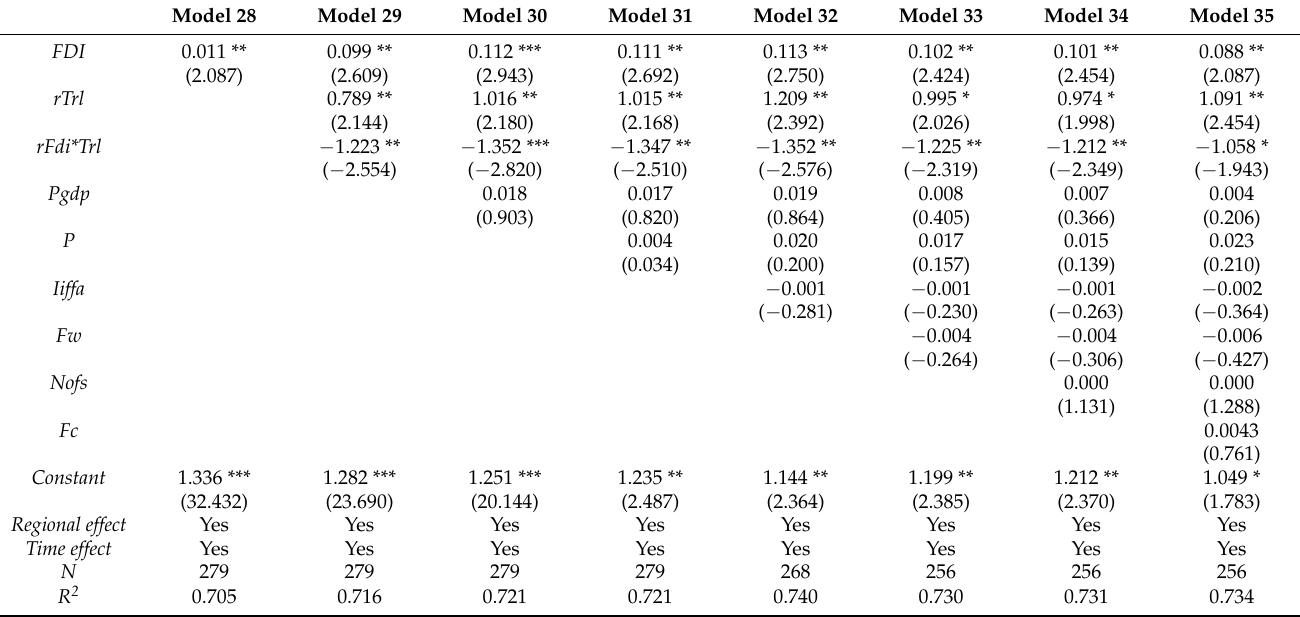
Table 10. Robustness test regression results for moderating